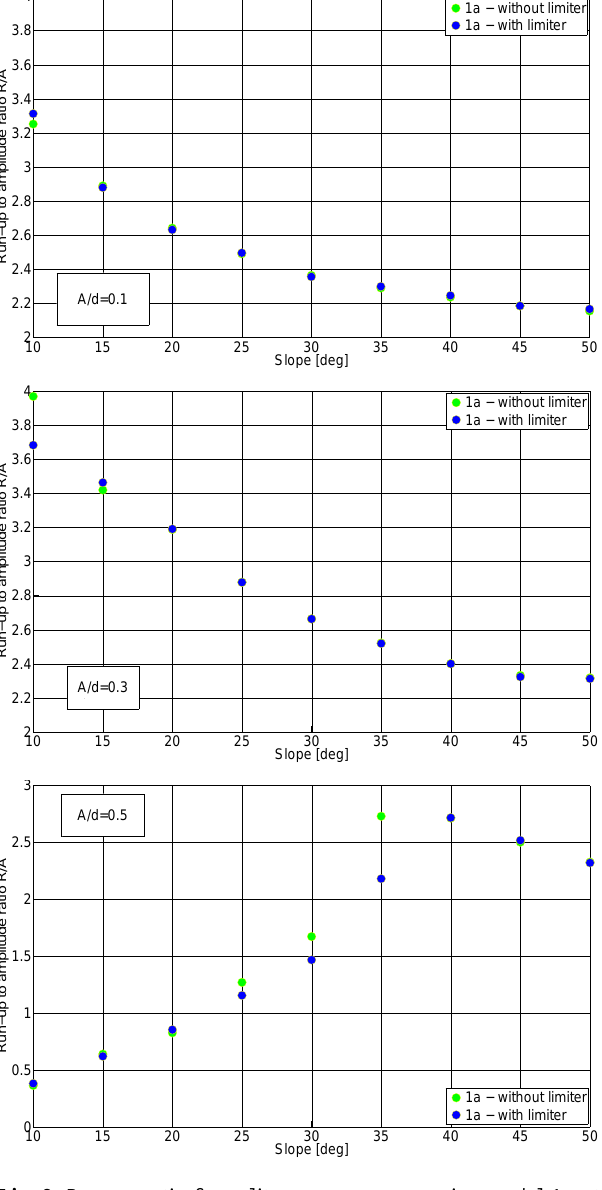
Fig. 6. Run-up ratio for solitary wave run-up using model 1a at different slopes. Results both with and without use of limiters are displayed. The Courant number is 0.1 and the spatial resolutions re- semble those in figure 4 with n = 200 points per wavelength. Upper panel, A/d = 0 . 1, mid panel A/d = 0 . 3, lower panel A/d = 0 . 5. The drop in the run-up ratio for the largest amplitudes in combina- tion with gentlest slope is due to model breakdown.